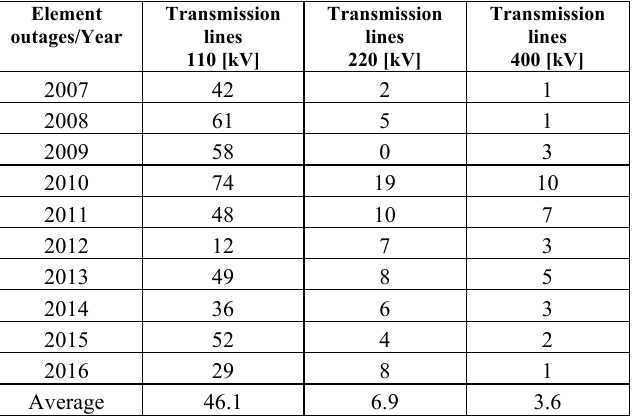
Table 4. Outages of transmission lines in Kosovo Power System regarding atmospheric discharges for years 2007-2016 and in average Element